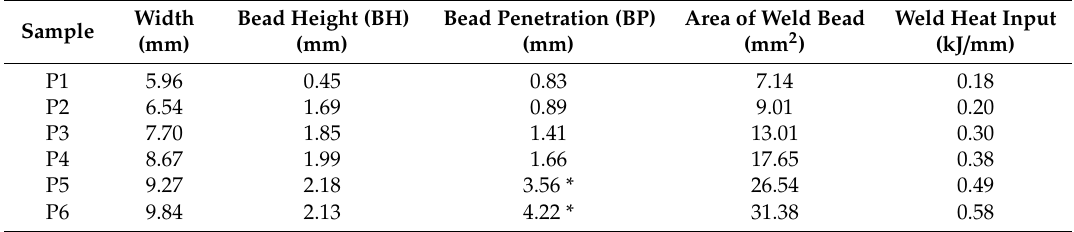
Table 4. The summary of weld dimensions as a result of di ff erent weld heat